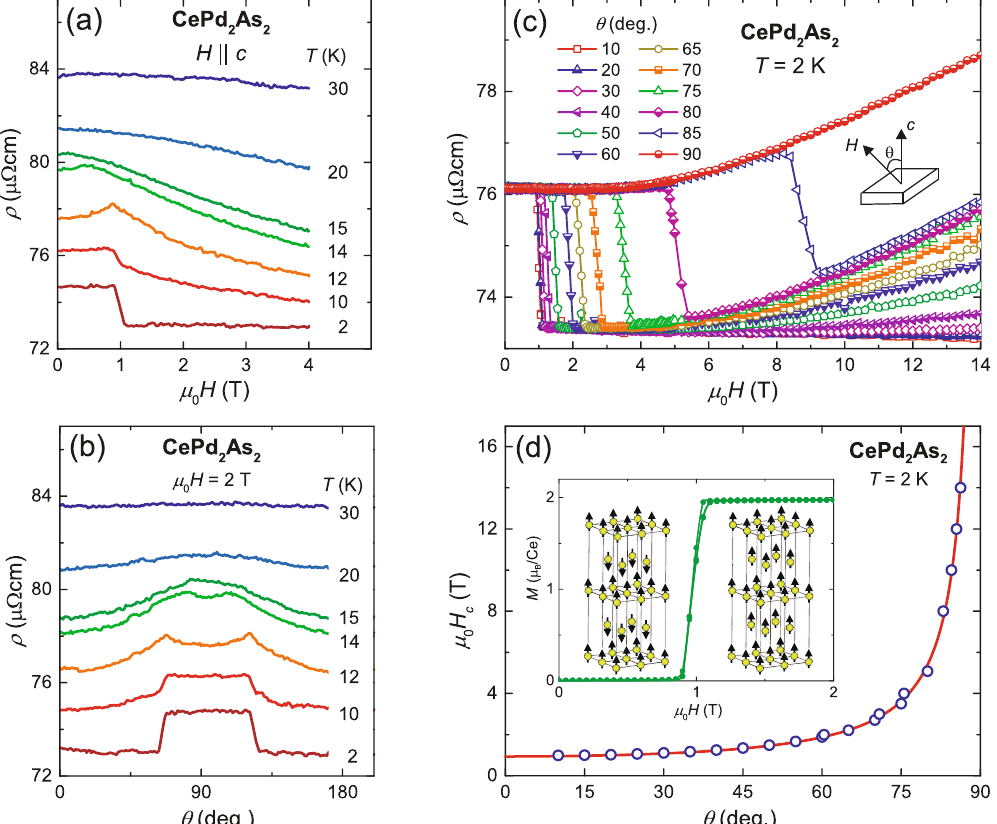
Figure 6. ( a ) Magnetic field dependence of ρ for field parallel to c -axis. ( b ) ρ as a function of the angle ( θ ) between the magnetic field H and c -axis at different temperatures. ( c ) Magnetic field dependence of ρ for different angles θ at T = 2 K. ( d ) Variation of metamagnetic critical field H c as function of θ at T = 2 K. The solid red line is a fit to the data using the equation H c = H c 0 /cos ( θ ). The inset illustrates the magnetic structures in the A-type antiferromagnetic and in the field-polarised phase.